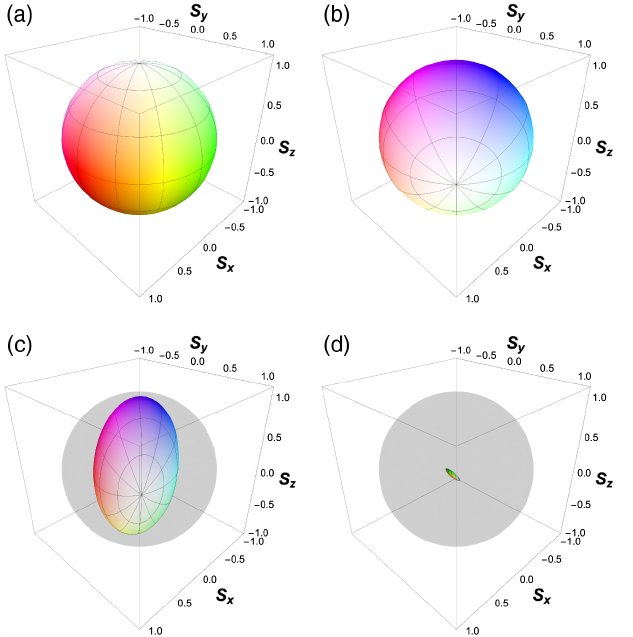
FIG. 10. Tomographic reconstruction of THP unitary operator. From top left to bottom right: (a) initial Bloch sphere of pure states, (b) simulation of that Bloch sphere under ideal THP , (c) experimental reconstruction with correct decryption, and (d) experimental reconstruction with bad decryption.